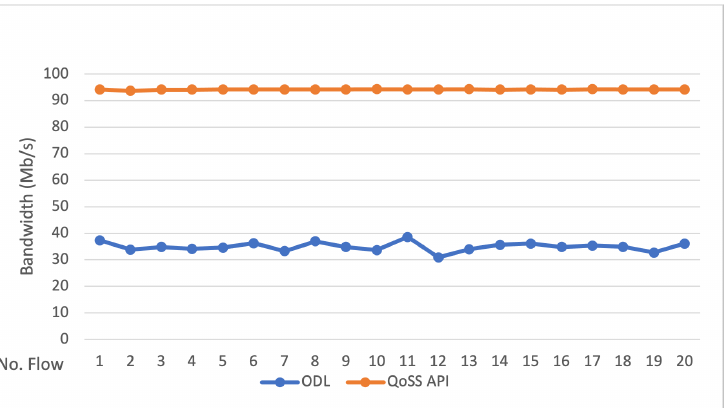
Figure 9. TCP Data transfer rate comparison. Controller default vs. QoSS API